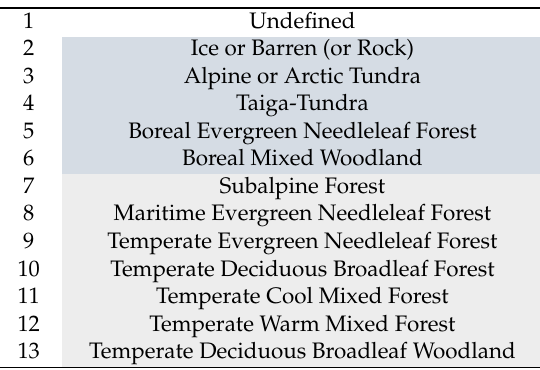
Table A1. MC2 potential vegetation